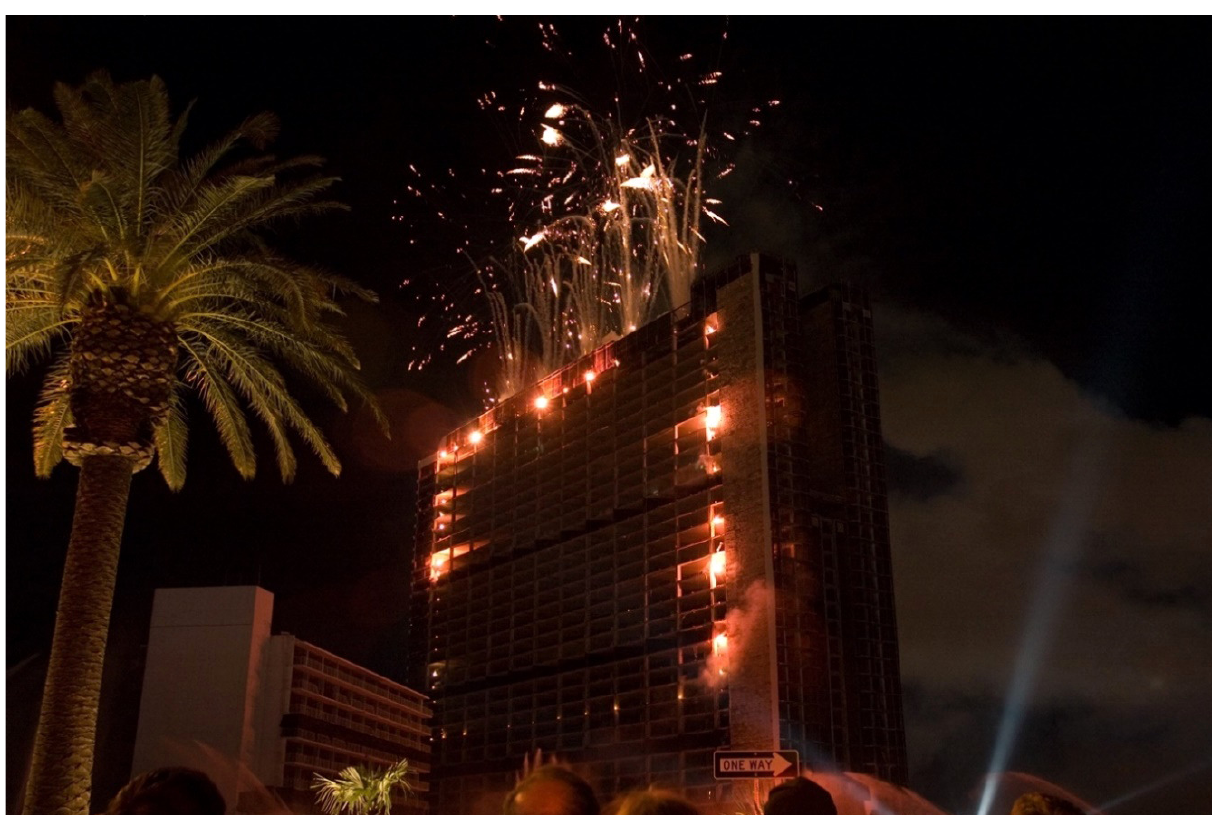
Figure 1. The spectacular night‐time implosion of the famed Stardust casino‐hotel‐resort in 2007, complete with special lighting and fireworks. Source: Courtesy of Andrew Ferguson via Creative